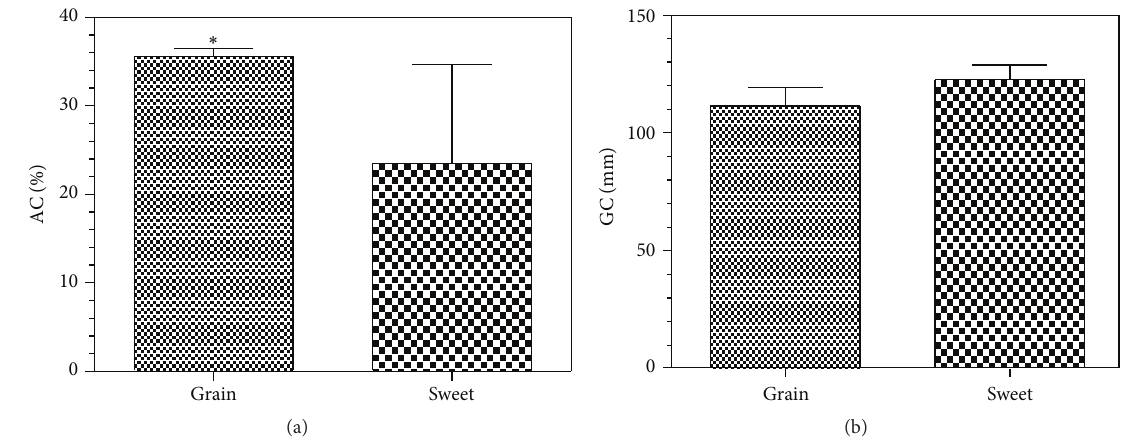
Figure 1: Comparison of the average amylose content (AC) (a) and gel consistency (GC) (b) of starches between sweet and grain varieties. ∗ indicates that significant difference was noticed ( 𝑝 < 0.05 ).